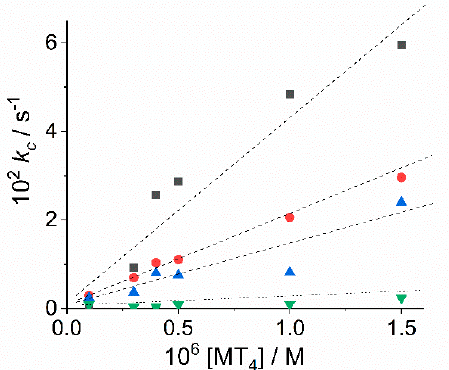
Figure 7. Plot of the autocatalytic rate constants k c (s − 1 ) for the aggregation of TPPS 4 as a function of [MT 4 ] for the various metal derivatives. AuT 4 (black squares), CoT 4 (red circles), MnT 4 (blue triangles), ZnT 4 (green triangles). (Experimental conditions: [TPPS 4 ] = 3 µ M; [HCl] = 0.00158 M, T = 298 K). The straight lines represent the linear fit to the rate data, according to the equation k c = k ’ MT 4 × [MT 4